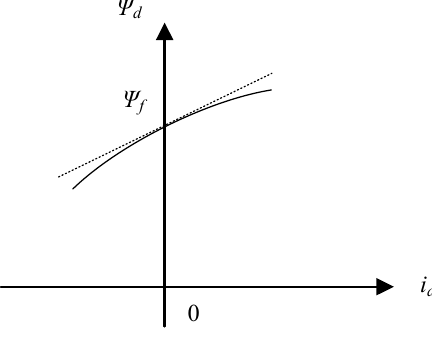
Figure 5. The relationship between Ψ d and i d .